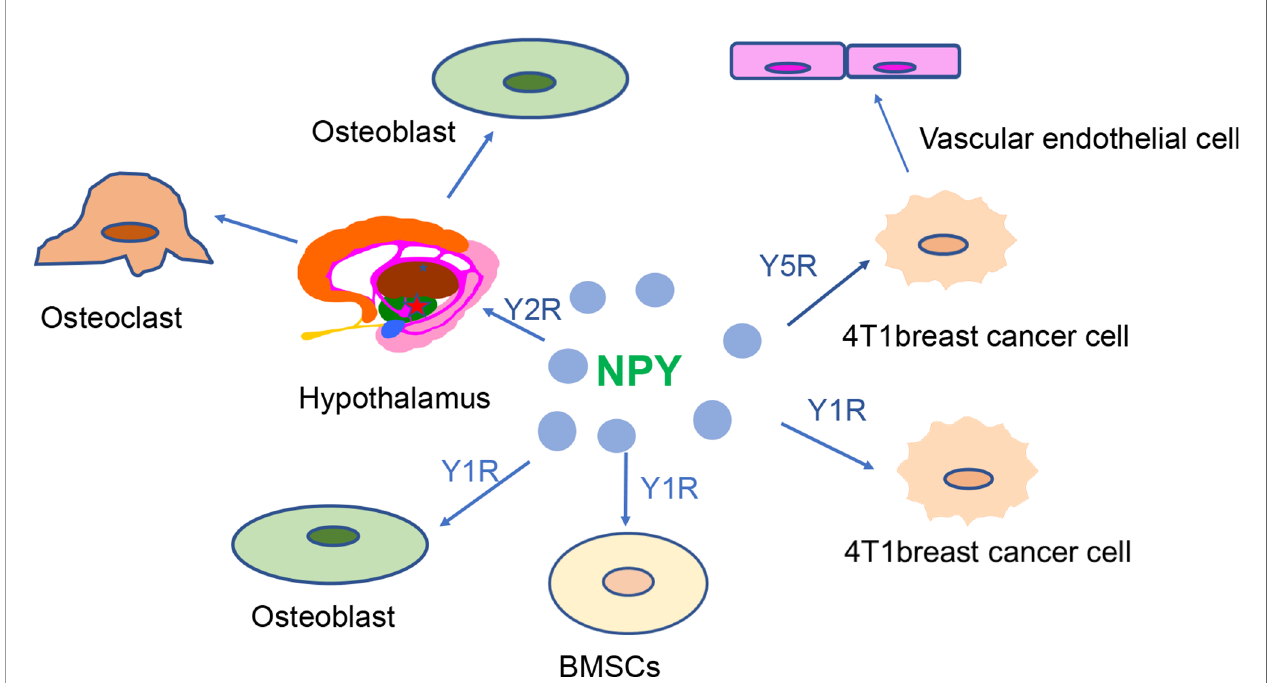
FIGURE 2 | NPY receptors are closely involved in the regulation of breast cancer and bone homeostasis. High expression of Y1R and Y5R is observed in 4T1 breast cancer cells. Y5R can promote the development of breast cancer by promoting the proliferation of vascular endothelial cells. The hypothalamic Y2R regulates bone balance by altering osteoblast and osteoclast proliferation. Alteration of Y1R may affect bone mass by regulating osteoblastic activity and bone marrow stem cell